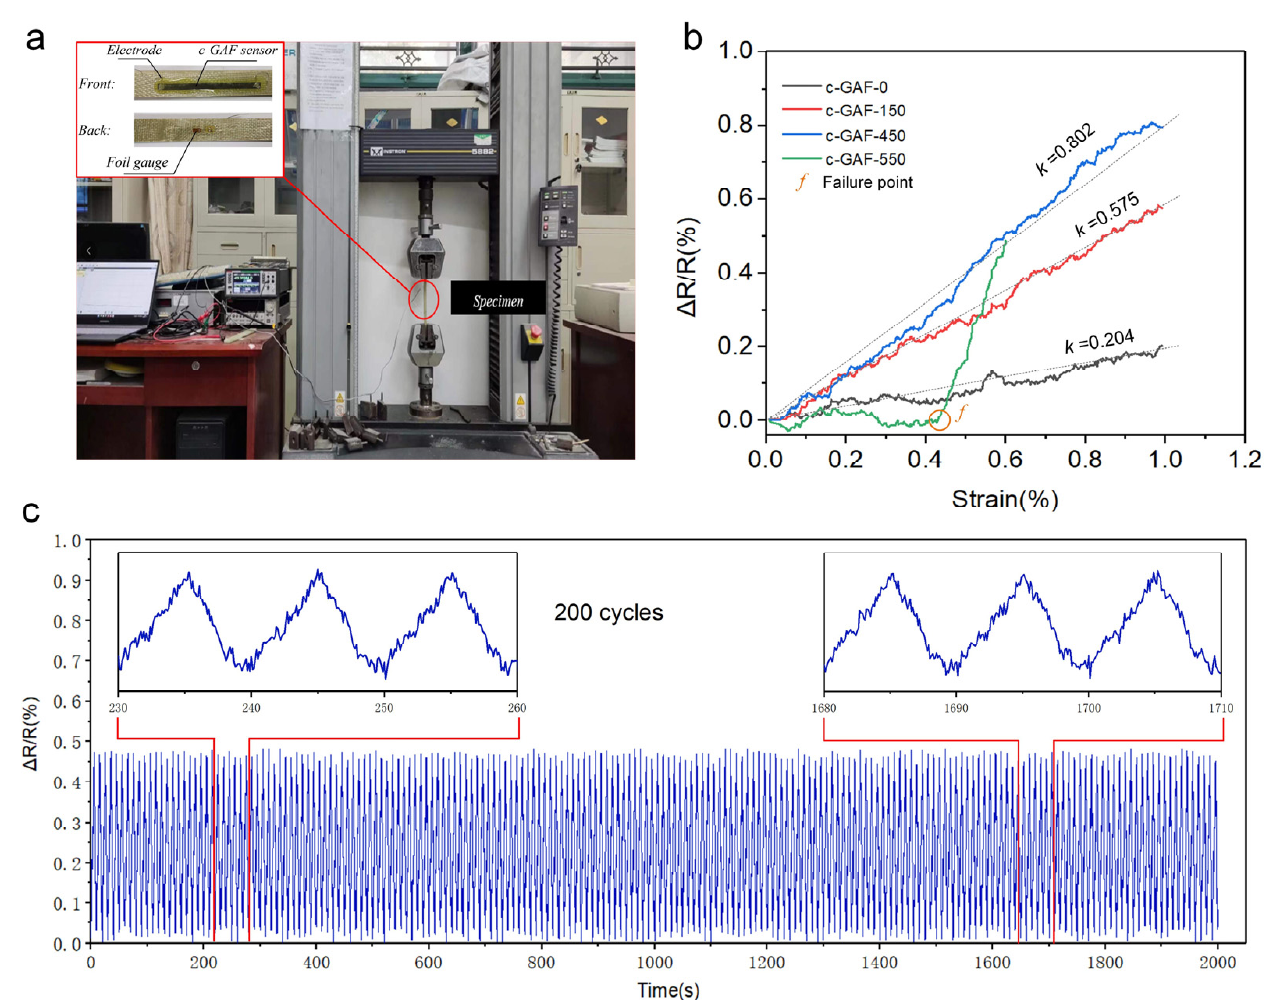
Figure 4. Performance of c-GAF strain sensors. ( a ) Photos of the specimen on the testing machine and the GFRP substrate with c-GAF and foil gauge strain sensor (inset). ( b ) Sensitivity test results for c-GAF strain sensors. ( c ) Resistance change of the c-GAF-450 strain sensor during the fatigue test ranged from 0–0.6%.